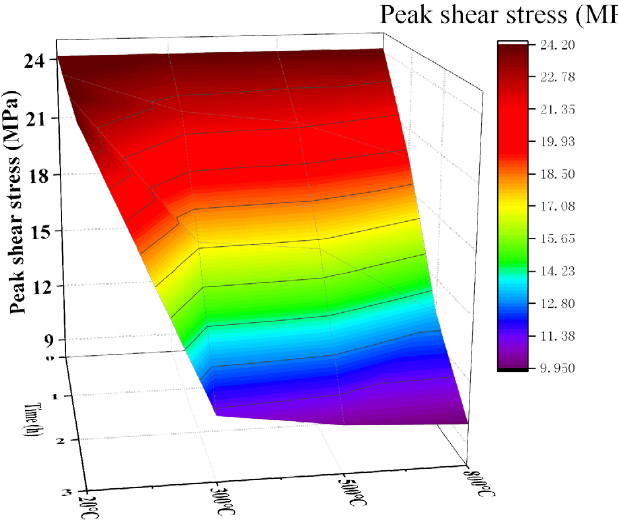
Figure 13. Shear strength of RTC (AG) under different geothermal conditions. In summary, the results of this research can achieve good applicability in a variety of different engineering